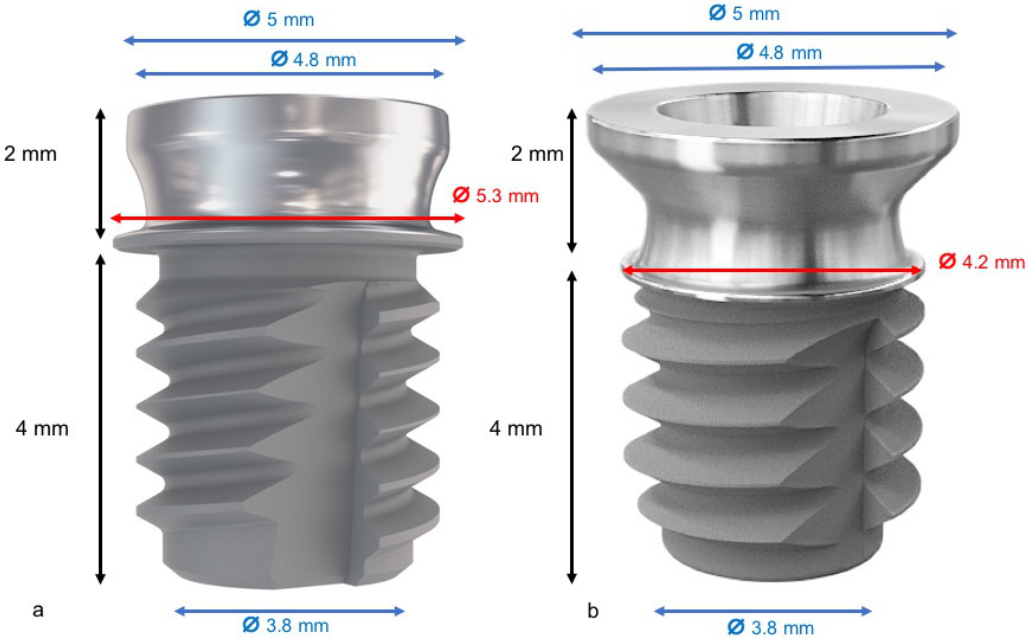
Figure 1. ( a ) Extra-short implant with wide cervical ring with a 5.3 mm diameter; ( b ) extra-short implant with a narrow cervical ring with a 4.2 mm diameter.